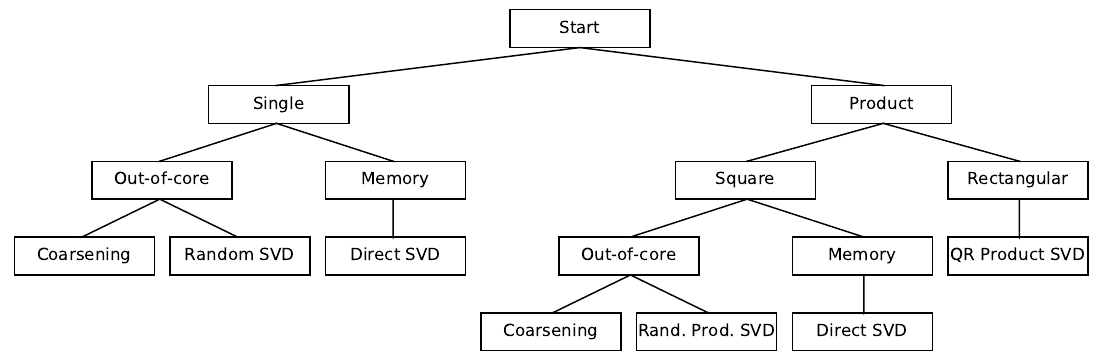
Figure 3. Decision tree describing the possible SVD techniques.